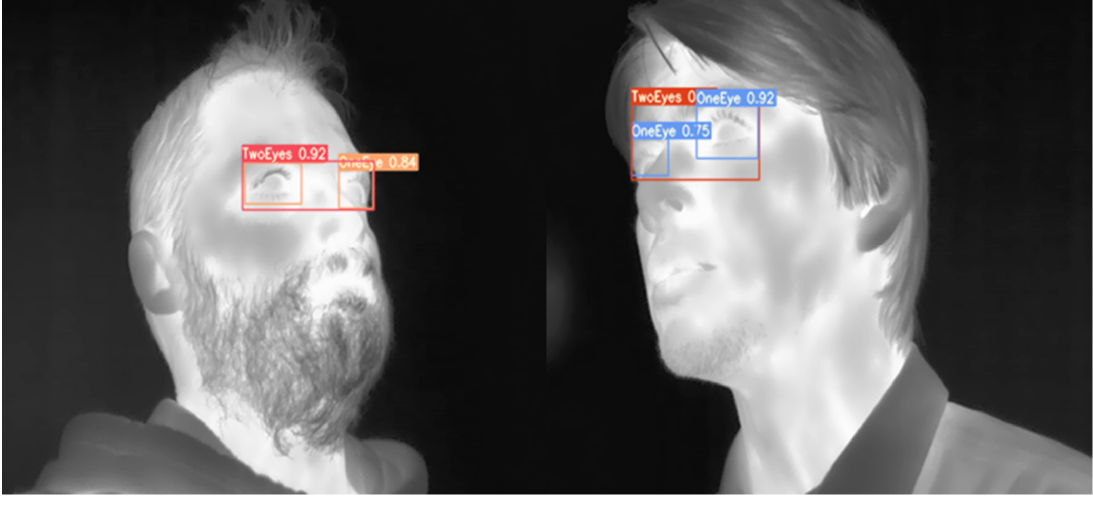
Figure 18. Detection of Eyes in Rotated Faces of the Dataset.